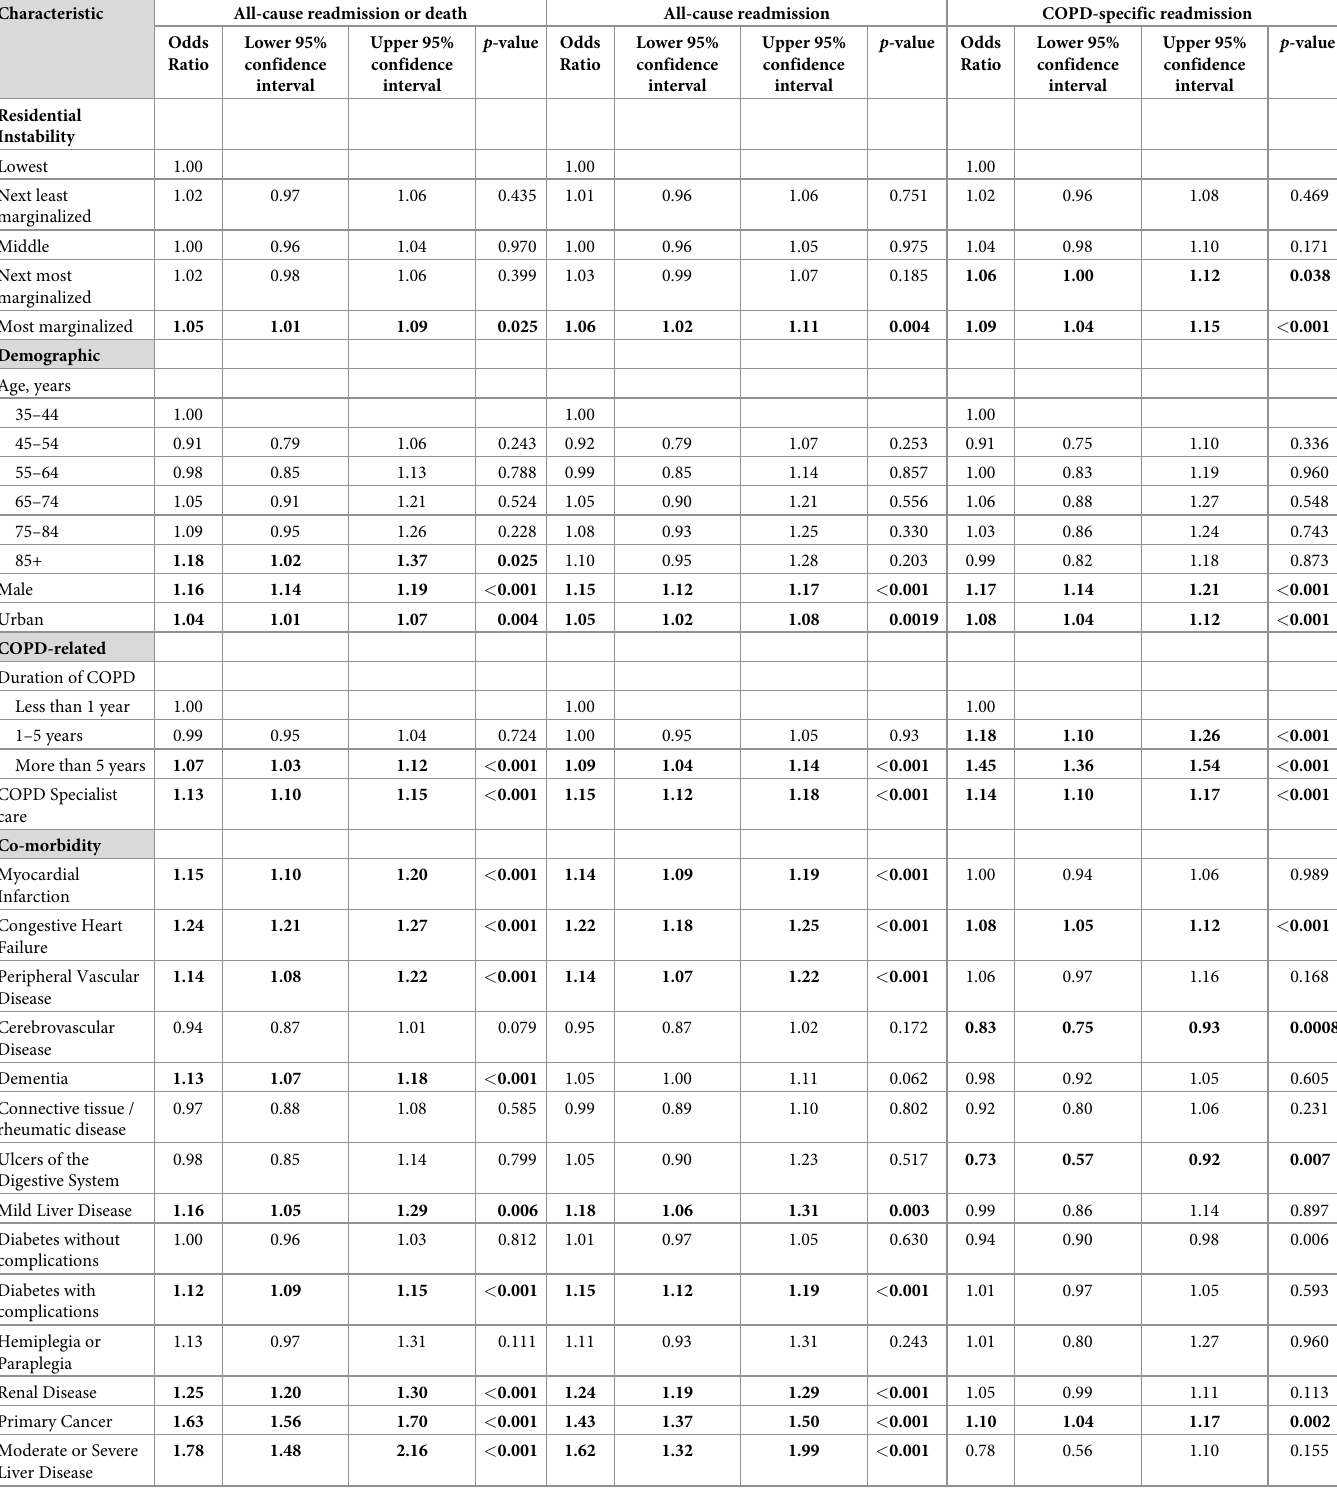
Table 3. Adjusted odds ratios (with 95% CI and p-values) of factors associated with different 30-day outcomes for Individuals with chronic obstructive pulmonary disease a .